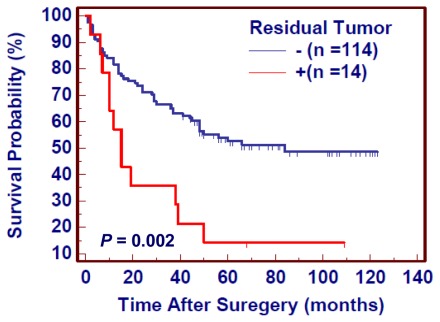
The effect of residual tumor after surgery on poor survival in gastric cancer. Survival was evaluated according to the presence of residual tumor after surgery in gastric cancers. Kaplan–Meier survival curves show that the patients with residual tumor had a significantly shorter survival time than the patients without residual tumor (P = 0.002). +, the patients with residual tumor; −, the patients without residual tumor.